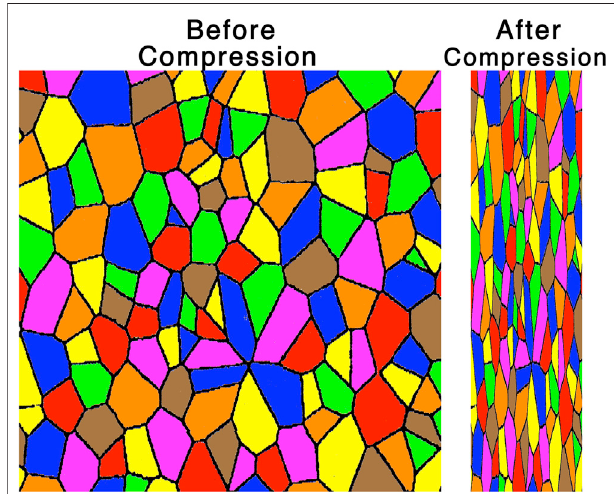
FIGURE4| Asketchofthepatternofcurrentsheets(blacklines)forming the walls of magnetic fl ux tubes as viewed looking along the Parker-spiral direction. In the left panel the pattern is viewed in uncompressed solar wind and in the right panel the plasma has been compressed (horizontally) by a factor of